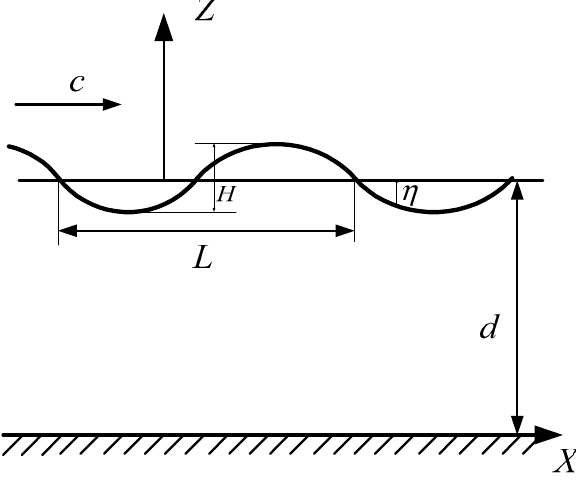
Figure 1. The schematic diagram of wave propagation.